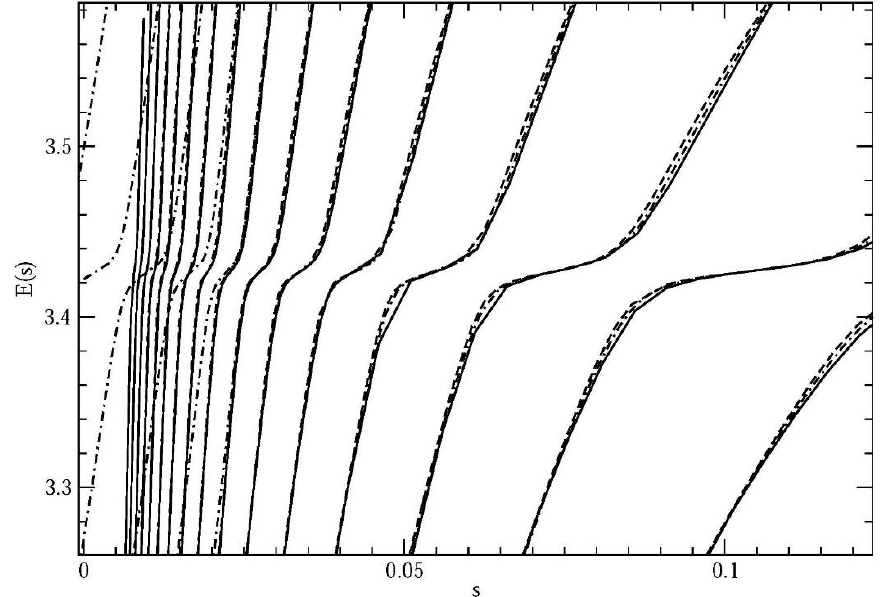
Figure 1. Function E ( s ) at s > 0 when the charge of the target z 0 = 0. The branches of the function Figure 1. Function   E s at 0 s  when the charge of the target E ( s ) correspond to problem I (solid lines), problem II for N = 100 (dashed lines), and problem III for function   E s correspond to problem I (solid lines), problem II for 100 N  (dashed lines), and N = 100, λ = 1.6 (dash-dotted lines). Data are presented in problem III for 100, 1.6 N   (dash-dotted lines). Data are presented in a.u.